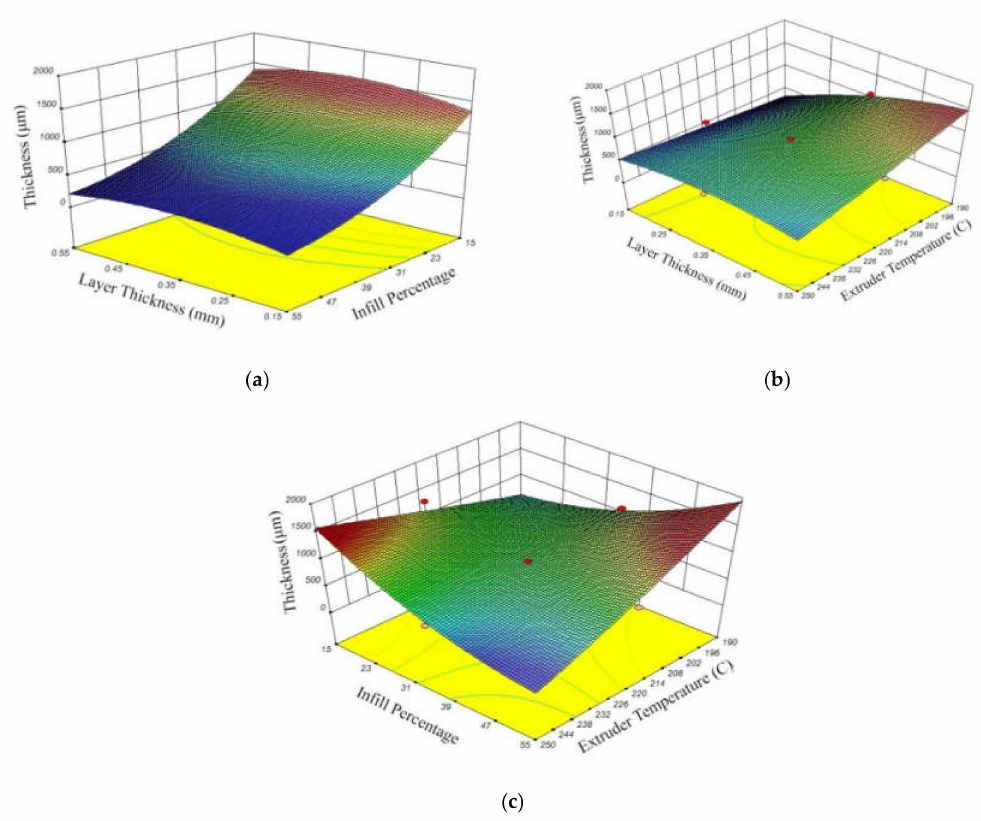
Figure 10. 3D surface plot of the maximum width with ( a ) infill percentage and layer thickness;